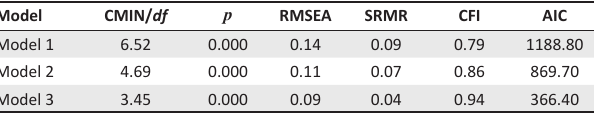
TABLE 4: Confirmatory factor analysis: Measurement model. Model CMIN/